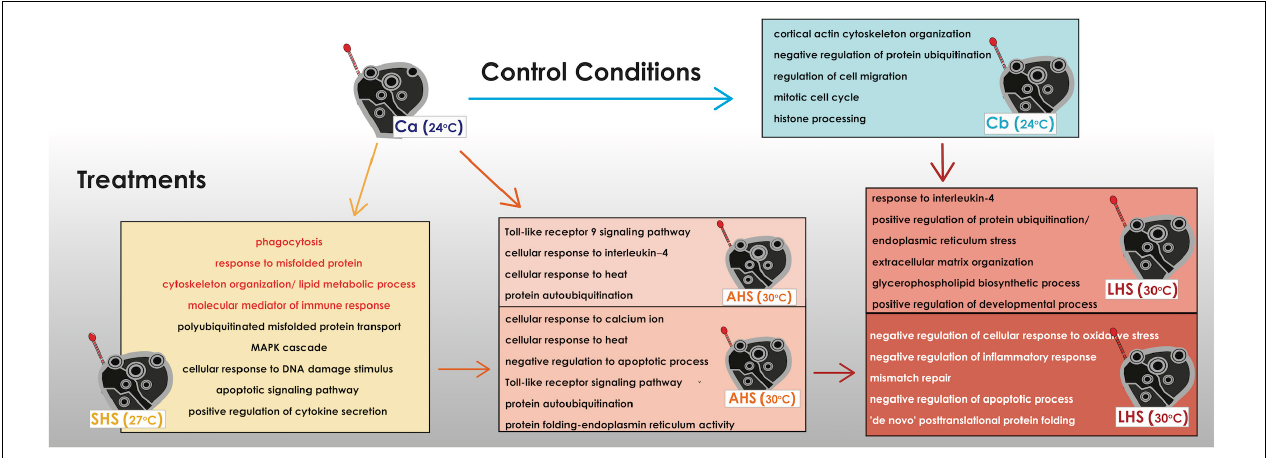
FIGURE 4 | Depiction of the overrepresented functional categories in each thermal condition when compared to the control condition or with other thermal conditions. The present functional categories of the last control condition (Cb) when compared to the former control condition (Ca) are also depicted. The functional categories come from the GO terms extracted from the upregulated genes in each comparison and/or the further enrichment of GO categories (data available in Supplementary Tables S5 , S6 ). In orange color are categories that are find common in the comparisons SHS vs. Ca and AHS vs. Ca.